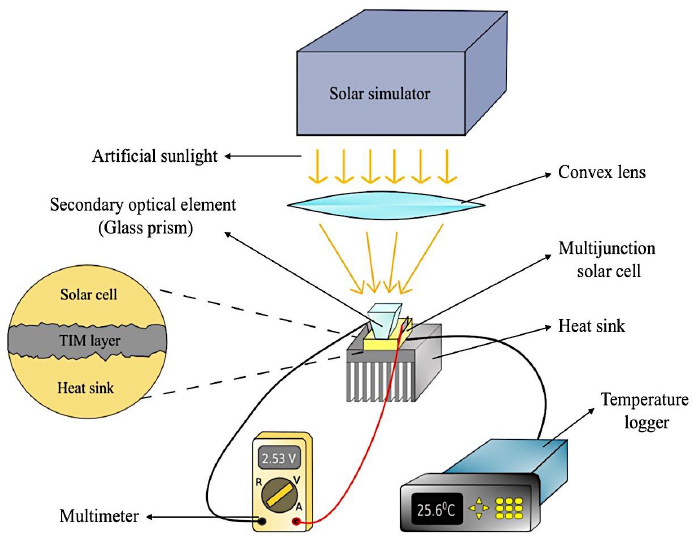
Figure 1. Schematic of the experimental setup with a solar cell attached to a heat sink. The convex lens was used to reach 200× suns illumination. Multi-meter and temperature logger were utilized to measure the open-circuit voltage, V OC , and the cell temperature every 5 s when the illumination was turned on.